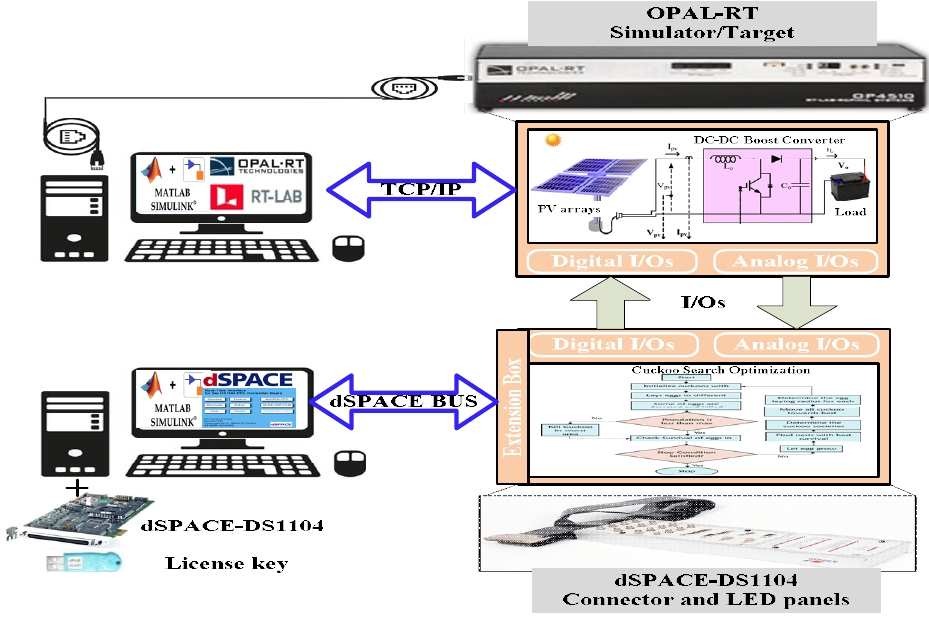
Figure 5. Hardware implementation of the MPPT techniques.